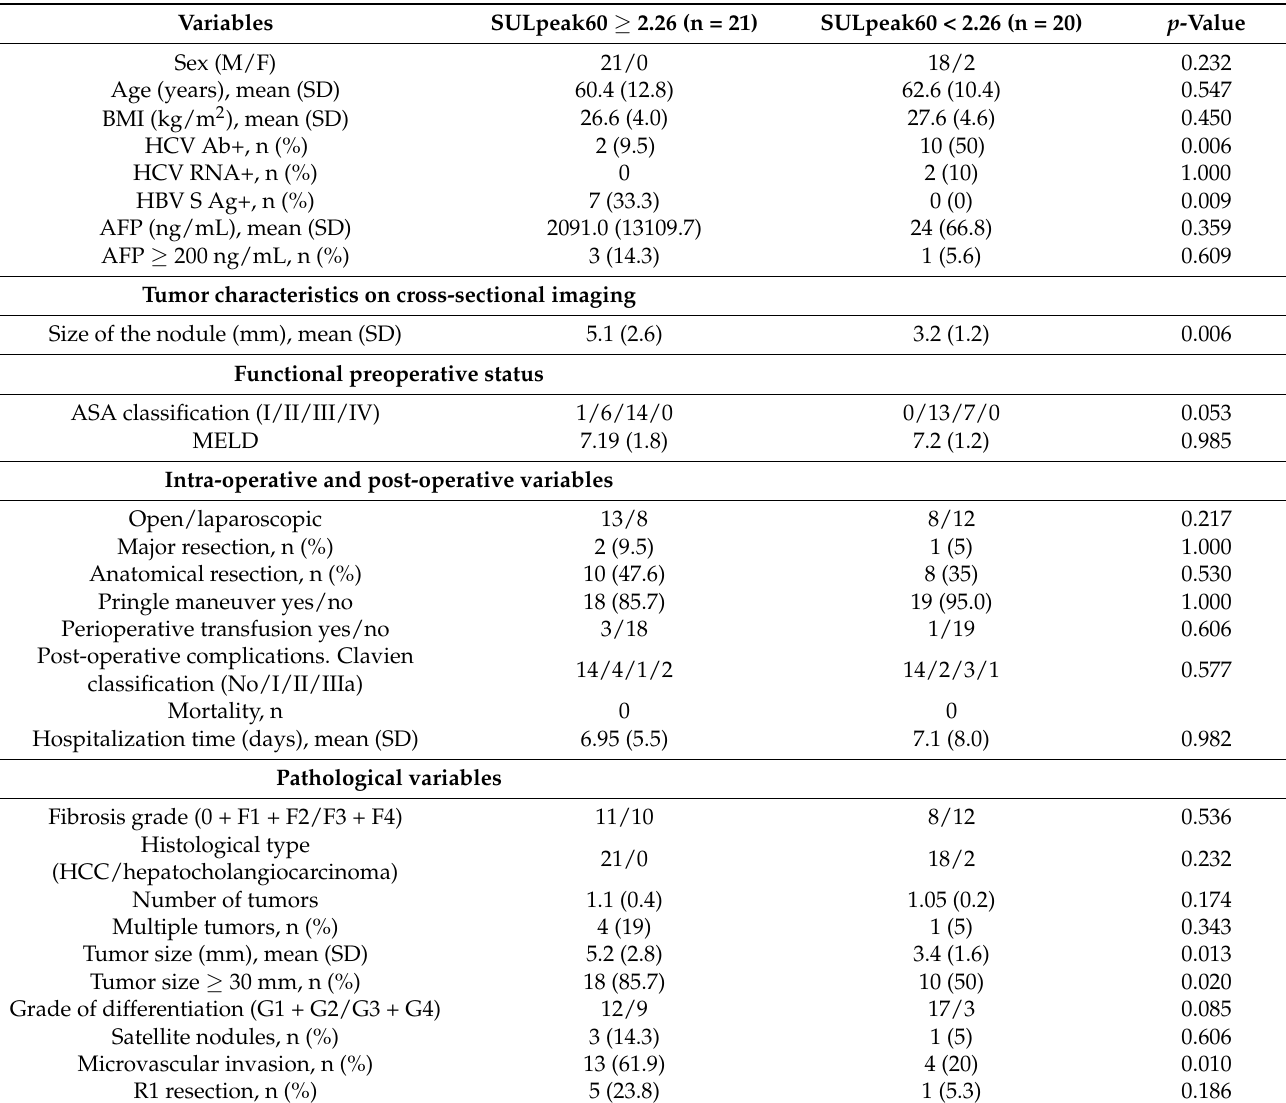
Table 3. Comparison between the two groups of patients according to the metabolic activity based on SULpeak60 with the cut-off in the p50